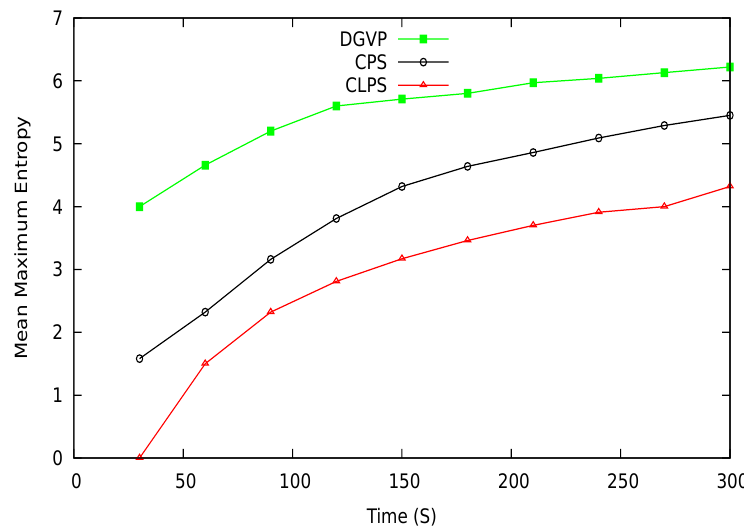
Figure 17. The entropy of vehicles at different periods on the road